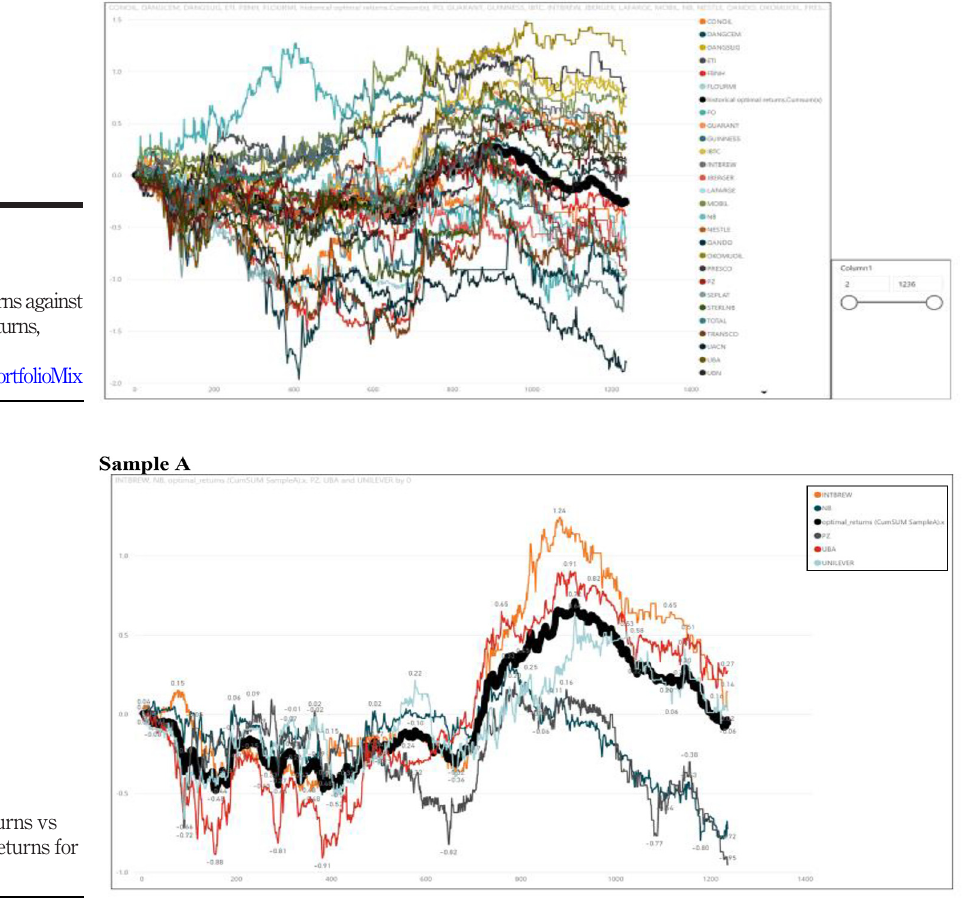
Figure 4. Optimal returns vs individual returns for Sample